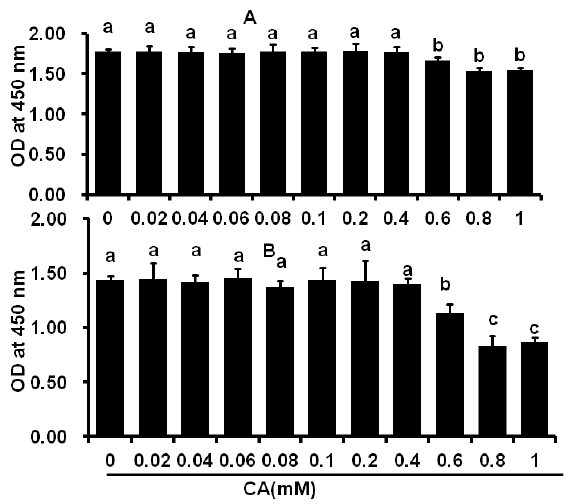
Figure 1. Cytotoxicity of coumaric acid on C2C12 skeletal muscle and 3T3-L1 preadipocytes. C2C12 skeletal and 3T3-L1 cells were incubated with coumaric acid at 0.02, 0.04, 0.06, 0.08, 0.1, 0.2, 0.4, 0.6, and 1 mM concentrations for 48 h. Coumaric acid (CA) did not possess any cytotoxicity effect on skeletal muscles and preadipocytess between the concentration ranges from 0.02 mM to 0.4 mM. ( A ) coumaric acid on C2C12 skeletal muscle; and ( B ) coumaric acid on 3T3-L1 preadipocytes. The results represent the mean ± SEM of six replicates. The different letters—a, b, c—within a treatment indicates significant differences ( p < 0.05).